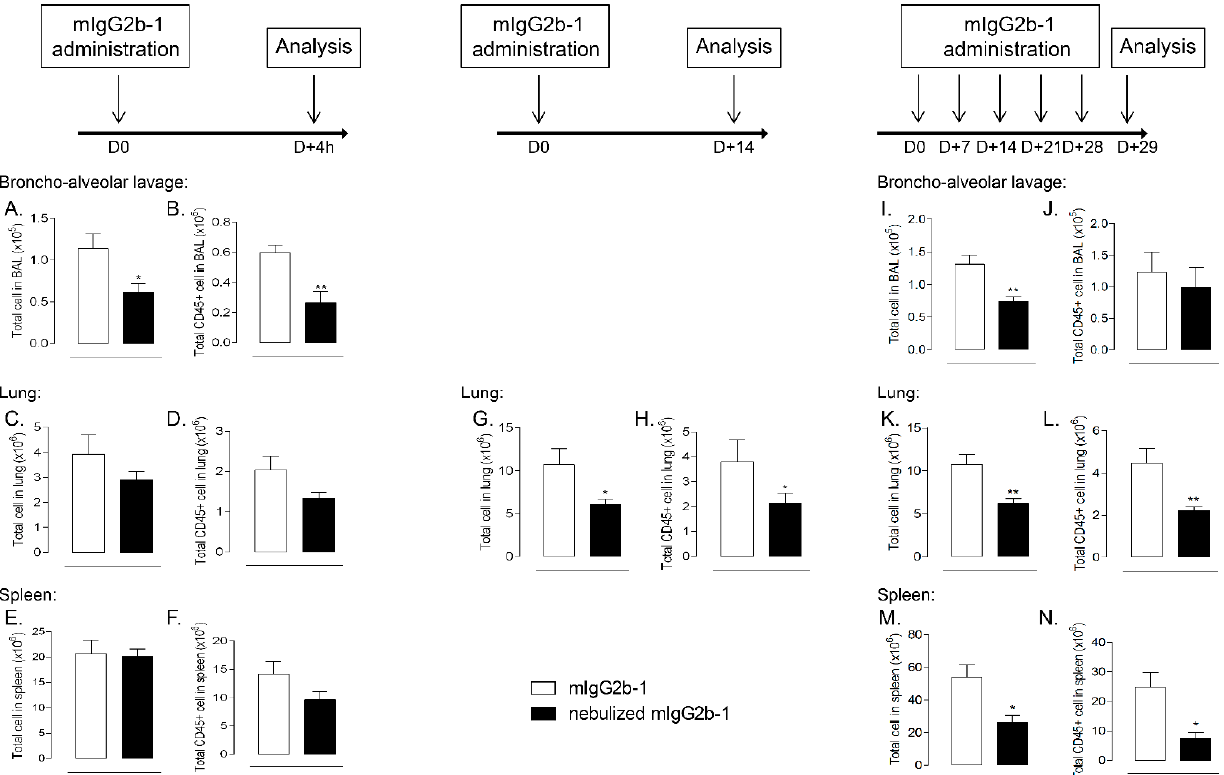
Figure 4. B6 mice received a 40 µL orotracheal instillation of mIg2b-1 at 100 µg/mL either native (white bars) or nebulized (black bars) through the airways at D0, or D + 0, D + 7, D + 14, D + 21 and D + 28. The total number of cells ( A , C , E , G , I , K , M ) and CD45+ cells ( B , D , F , H , J , L , N ) were quantified in BAL ( A , B , I , J ), in the lungs ( C , D , G , H , K , L ) and the spleen ( E , F , M , N ) using flow cytometry, 4 h, 14 days or 29 days after the first administration. The data are quoted as the mean ± SEM. *, **: p < 0.05 and p < 0.01, respectively, in a t-test. The results are representative of two independent experiments ( n = 5